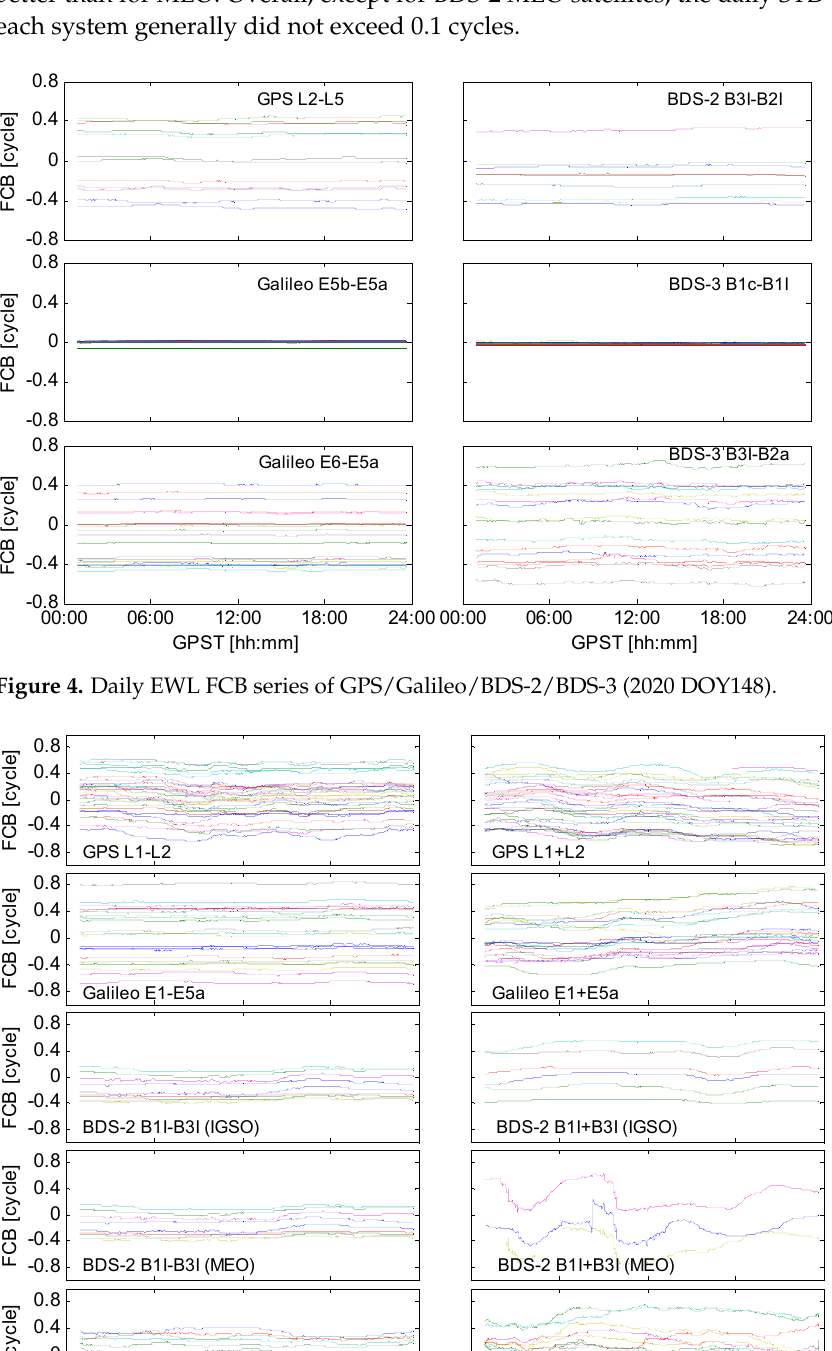
Figure 5. Daily WL (left) and NL (right) FCB series of GPS/Galileo/BDS-2/BDS-3 (2020 DOY148). Table 4. Daily STD statistical results of GPS/Galileo/BDS-2/BDS-3 WL and NL FCB.